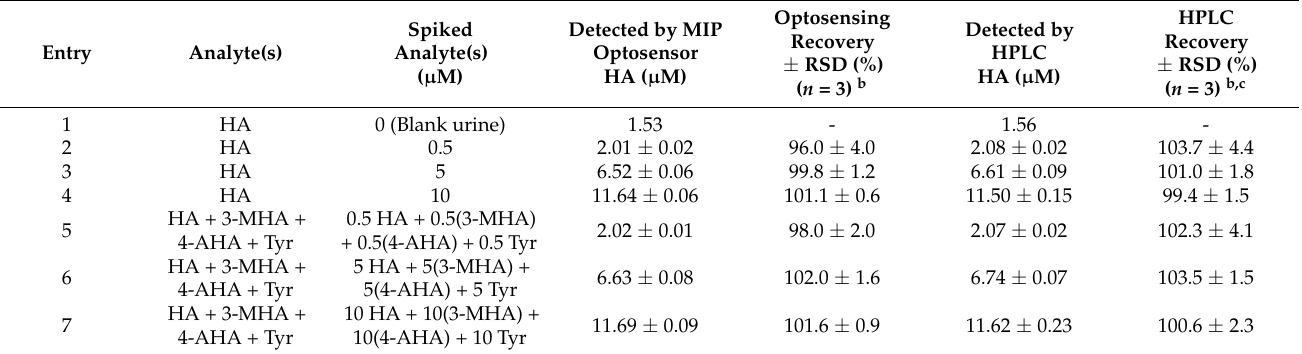
Table 2. Direct detection of HA in the undiluted urine samples at three spiking levels of both HA and its mixtures with several analogues with the hydrophilic fluorescent hollow HA-MIP a